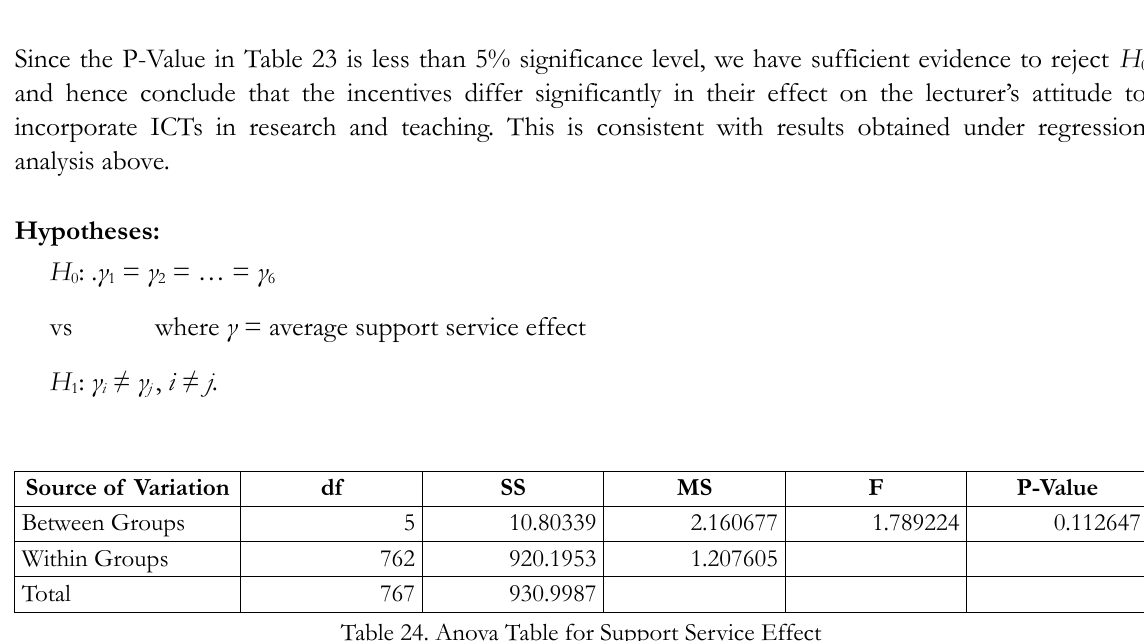
Table 23. Anova Table for Incentive Effect